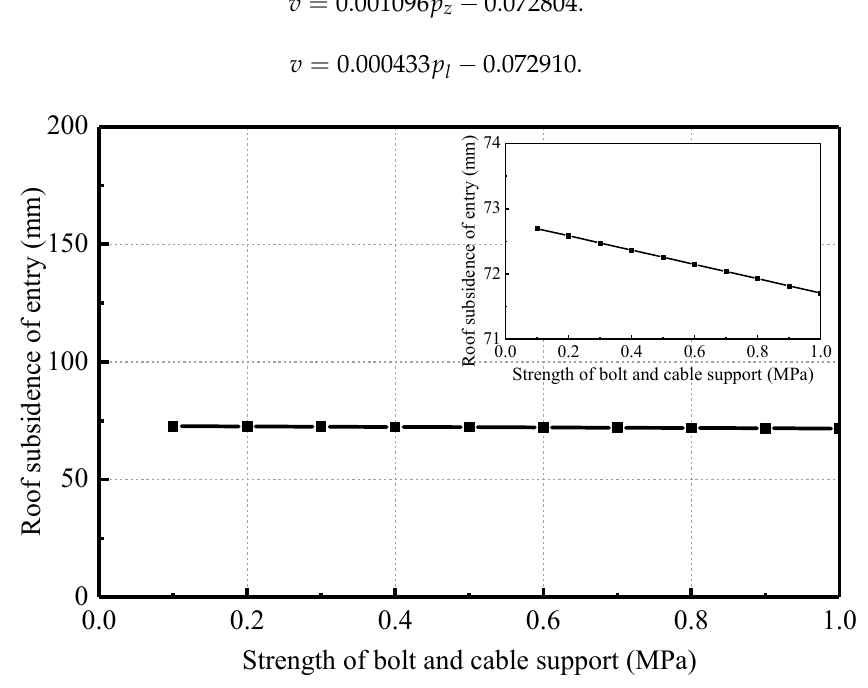
Figure 7. Relationship between roof deformation and bolt and cable support strength.